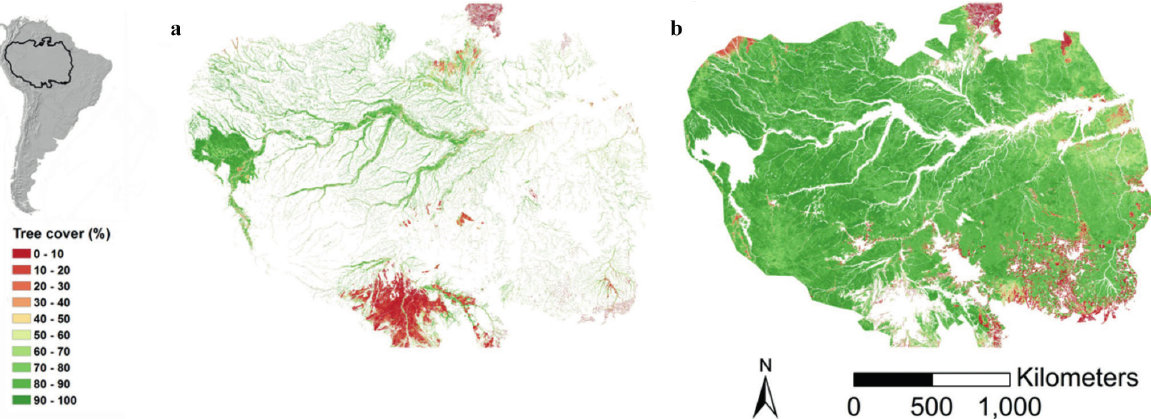
Figure 1 - Distribution of tree cover across the Amazon basin. ( a ) Floodplains and ( b ) uplands separated by the wetlands’ mask (Hess et al. 2015). Figure from Flores et al.